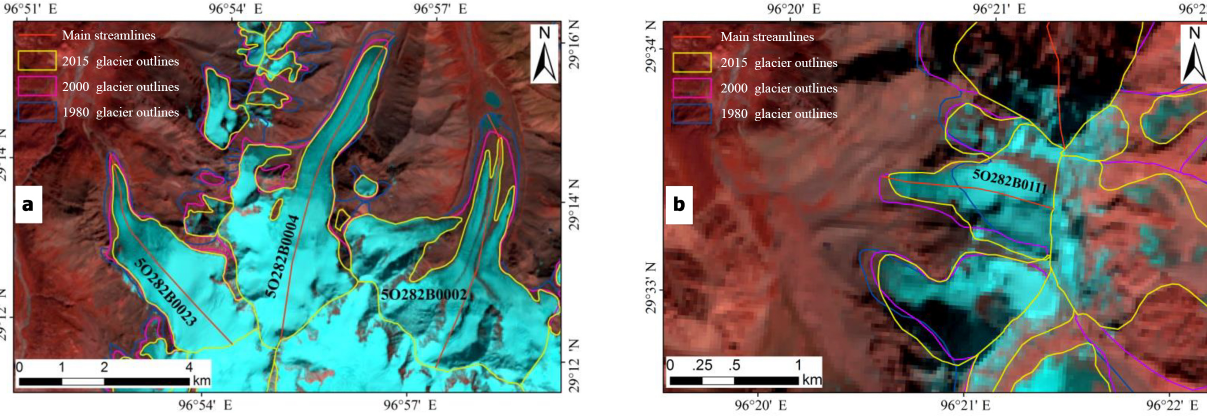
snow, supraglacial boulders and debris-covered ice (Fig.